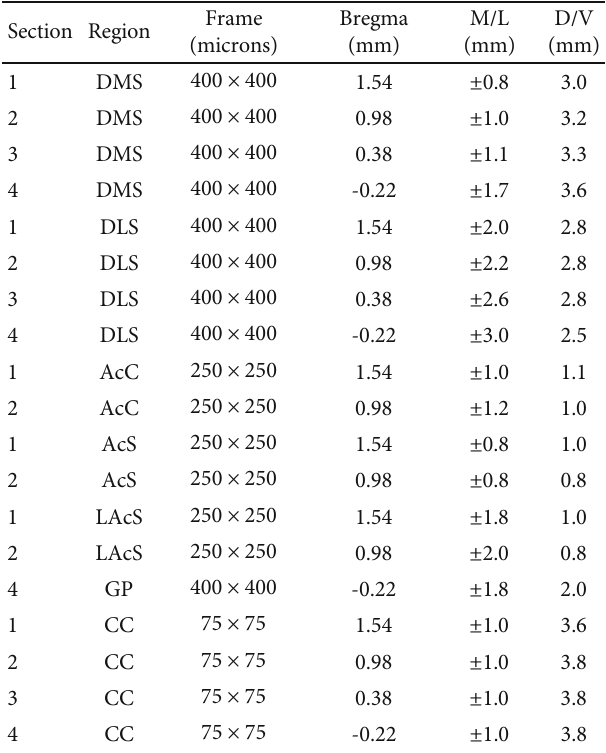
Table 1: Stereotaxic coordinates and frame size used for